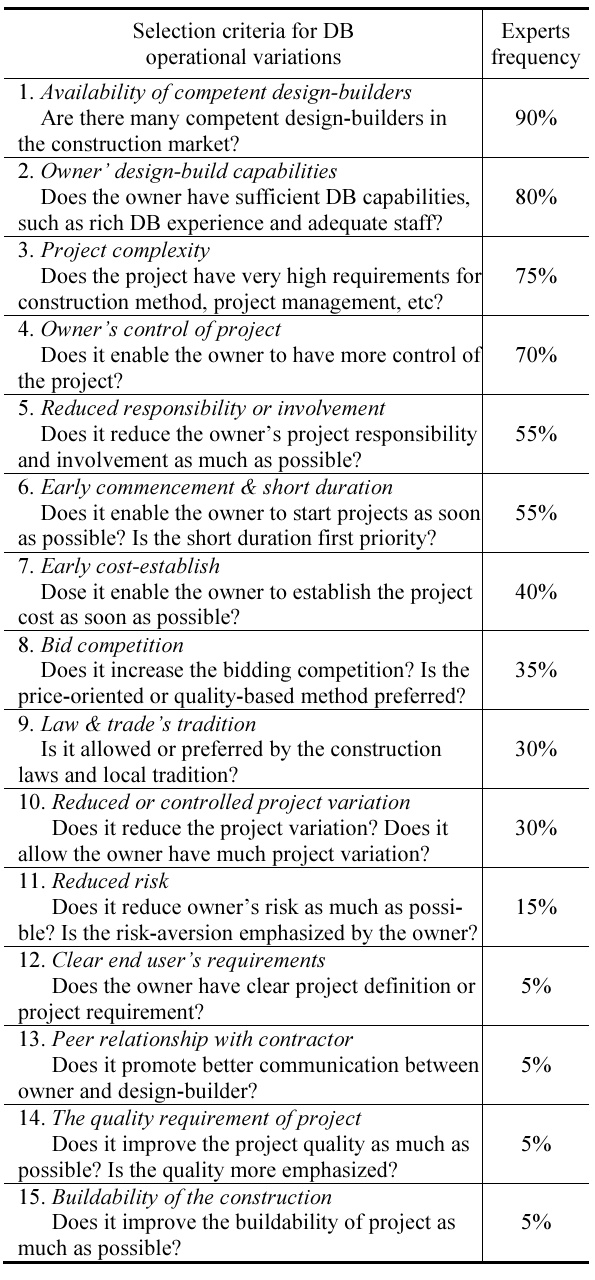
Table 4. Criteria provided by the panel of experts in round one Delphi survey